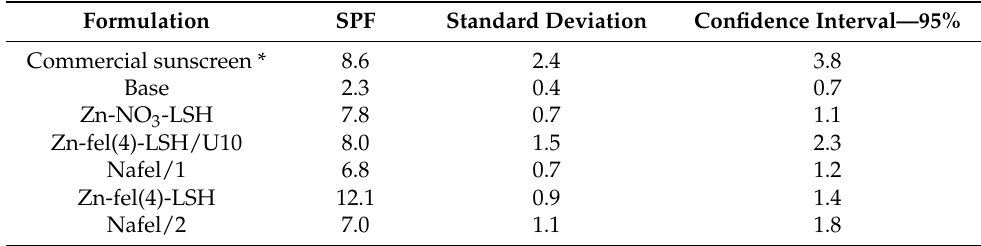
Table 4. In vitro SPF values of commercial sunscreen product, base, Zn-NO 3 -LSH,